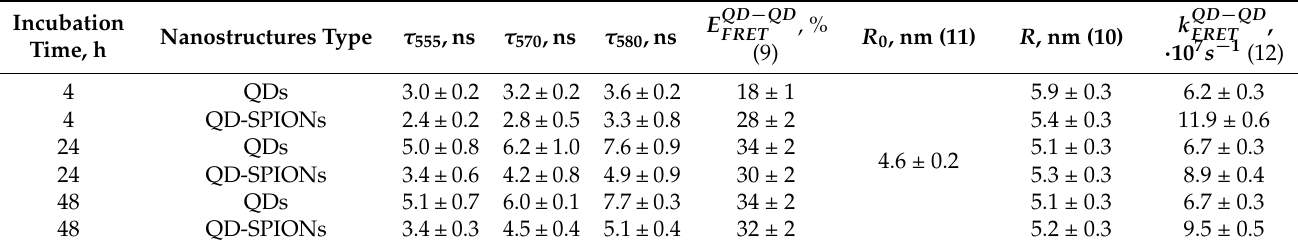
Table 2. Parameters of the QD–QD interaction for free QDs and QD-SPION nanocomposites in cells *.